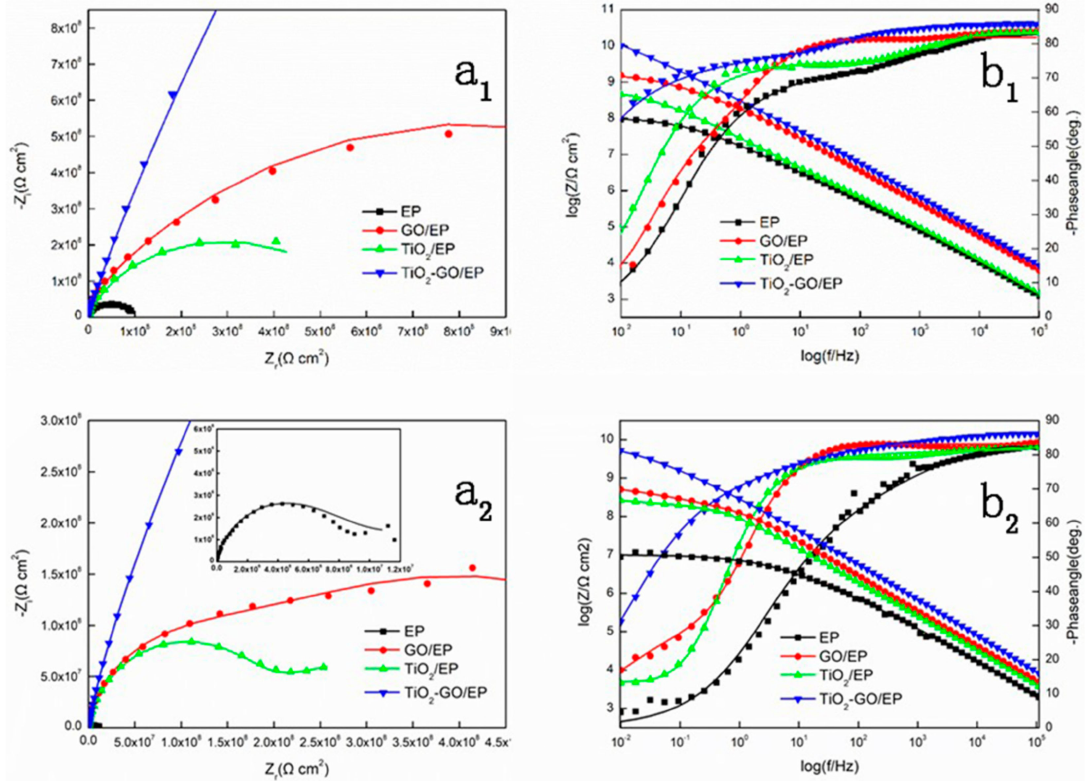
Figure 9. Nyquist( a 1 ) and Bode( b 1 ) spectrum after immersing 1 h; Nyquist( a 2 ) and Bode( b 2 ) spectrum after immersing 120